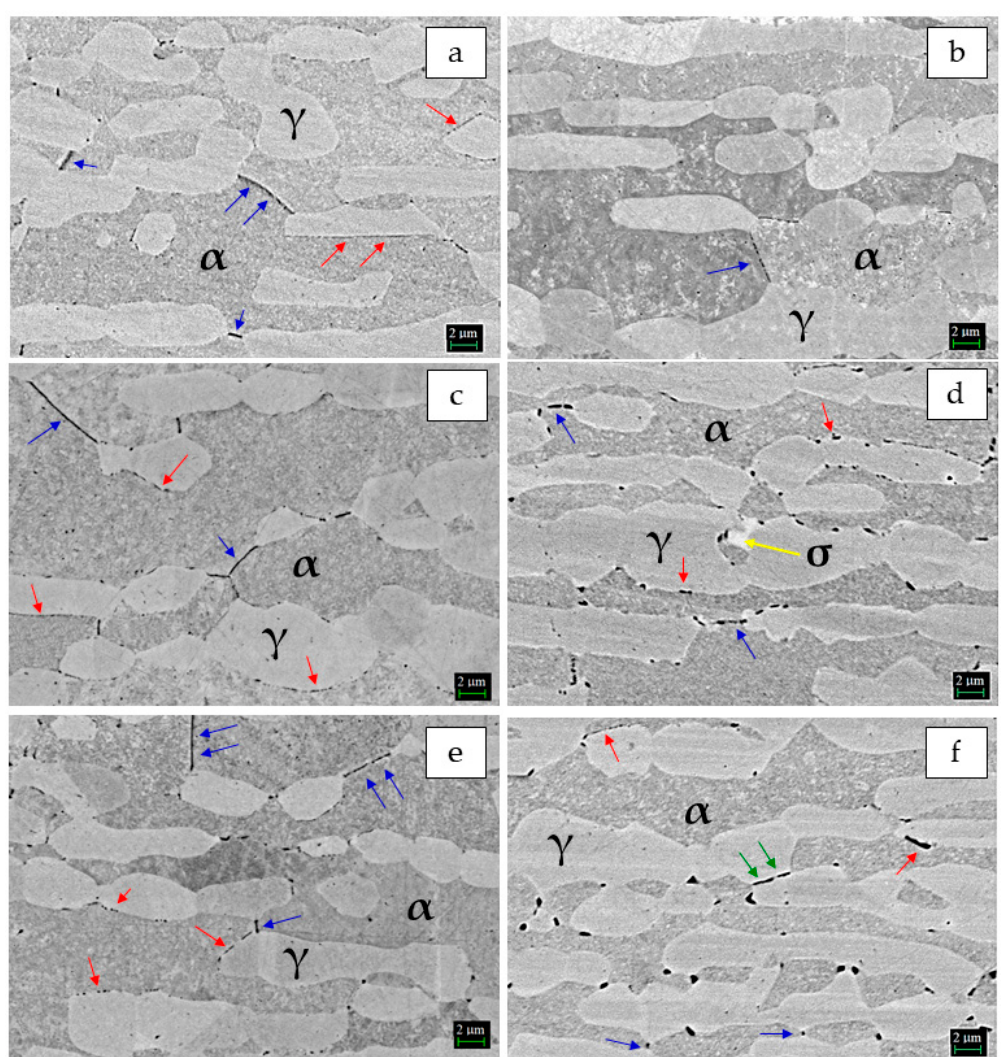
Figure 2. SEM (at backscattered electrons—BSE) micrographs of LDSS 2404 aged for: 60 min at 650 °C ( a ), 5 min ( b ), 10 min ( c ) and 60 min ( d ) at 750 °C, and 5 min ( e ) and 60 min ( f ) at 850 °C.